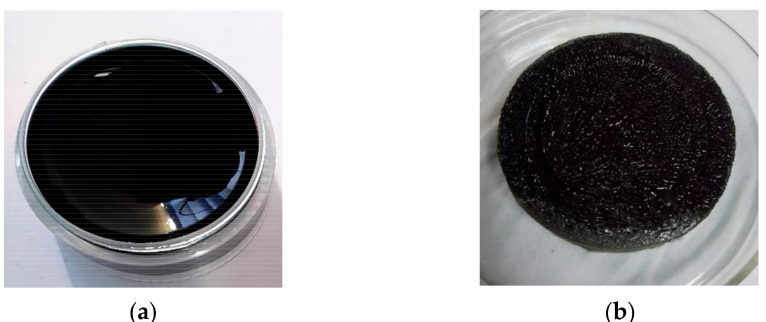
Figure 4. Photographic image of ( a ) hydrogel and ( b ) membrane foam of the chitosan–gelatin sample with the chitosan:gelatin composition ratio of